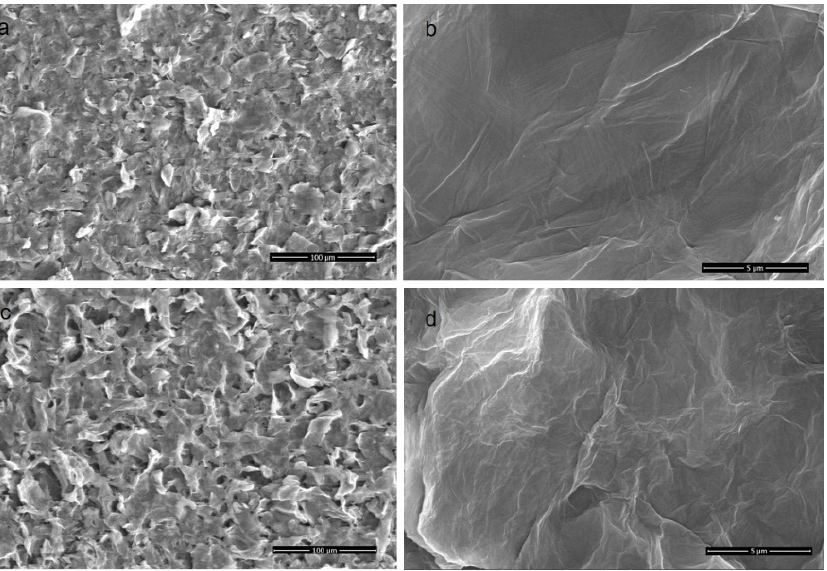
Figure 3. SEM images of the top surface of membranes with different chitosan content (( a , b ): pure GO membrane; ( c , d ) GO membrane with chitosan).